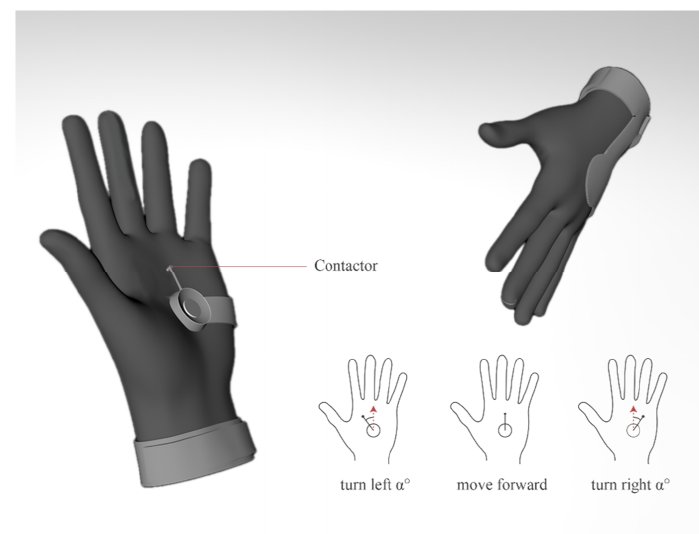
Figure 4. The design concept of the guidance glove.